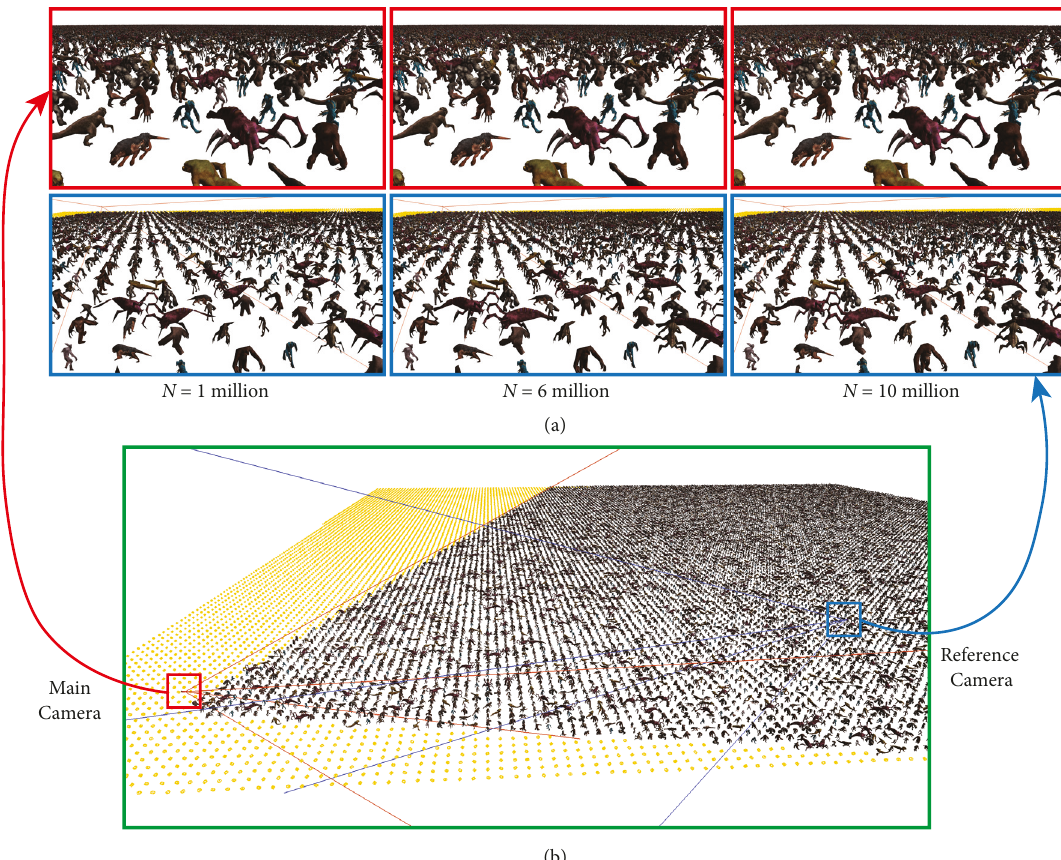
Figure5:Anexampleoftherenderingresultproducedbyoursystemusingdifferent 𝑁 values.(a)showsthecapturedimageswith 𝑁 = 1,6, 10 million. The top images are the rendered frame from the main camera. The bottom images are rendered based on the setting of the reference camera, which aims at the instances that are far away from the main camera. (b) shows the entire crowd including the view frustums of the two cameras. The yellow dots in (b) represent the instances outside the view frustum of the main